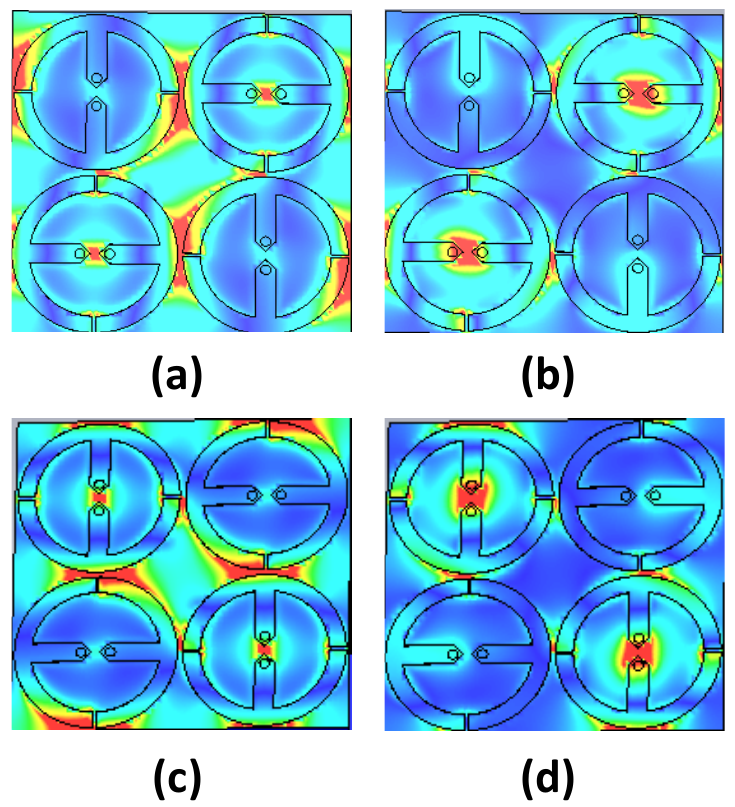
Figure 11. Obtained results of the implemented supercell illustrating the magnitude of the E-field across the surface of the proposed super unit cell by the red colour for ( a ) TE mode (Polarization 1) at 1.9 GHz, ( b ) TE mode (Polarization 1) at 5 GHz, ( c ) TM mode (Polarization 2) at 1.9 GHz, and ( d ) TM mode (Polarization 2) at 5